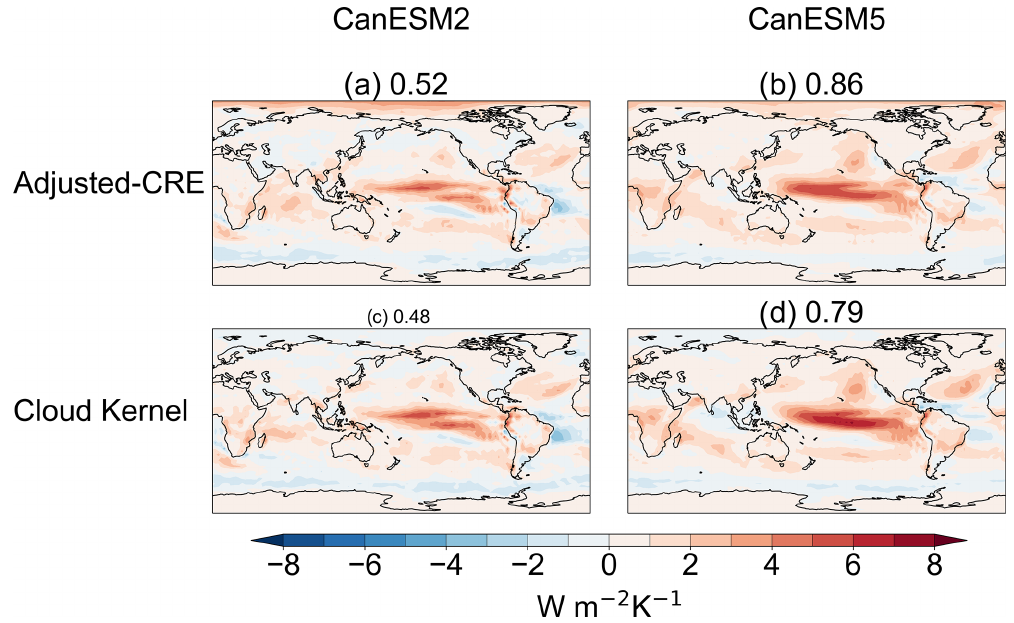
Figure A3. Comparison of annual mean net cloud feedbacks for CanESM2 (a, c) and CanESM5 (b, d) , calculated using the adjusted-CRE method and the cloud kernel method. Global mean values are shown in square brackets next to each subplot title. CanESM2 Pearson’s r = 0 . 72 ( p < 0 . 01), and CanESM5 Pearson’s r = 0 . 86 ( p < 0 . 01).